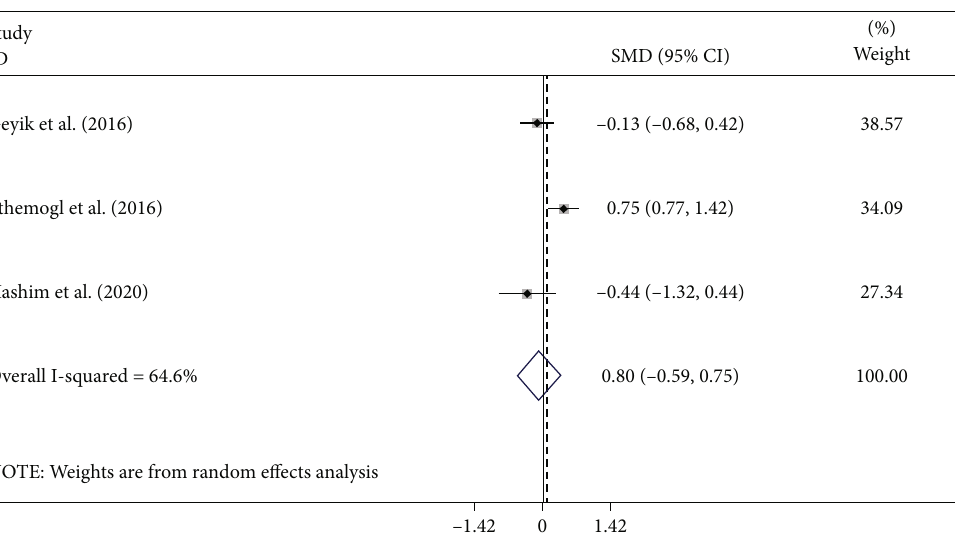
Figure 11: Meta-analysis of di ff erences in NLR levels between patients with AIDP and AMAN GBS.